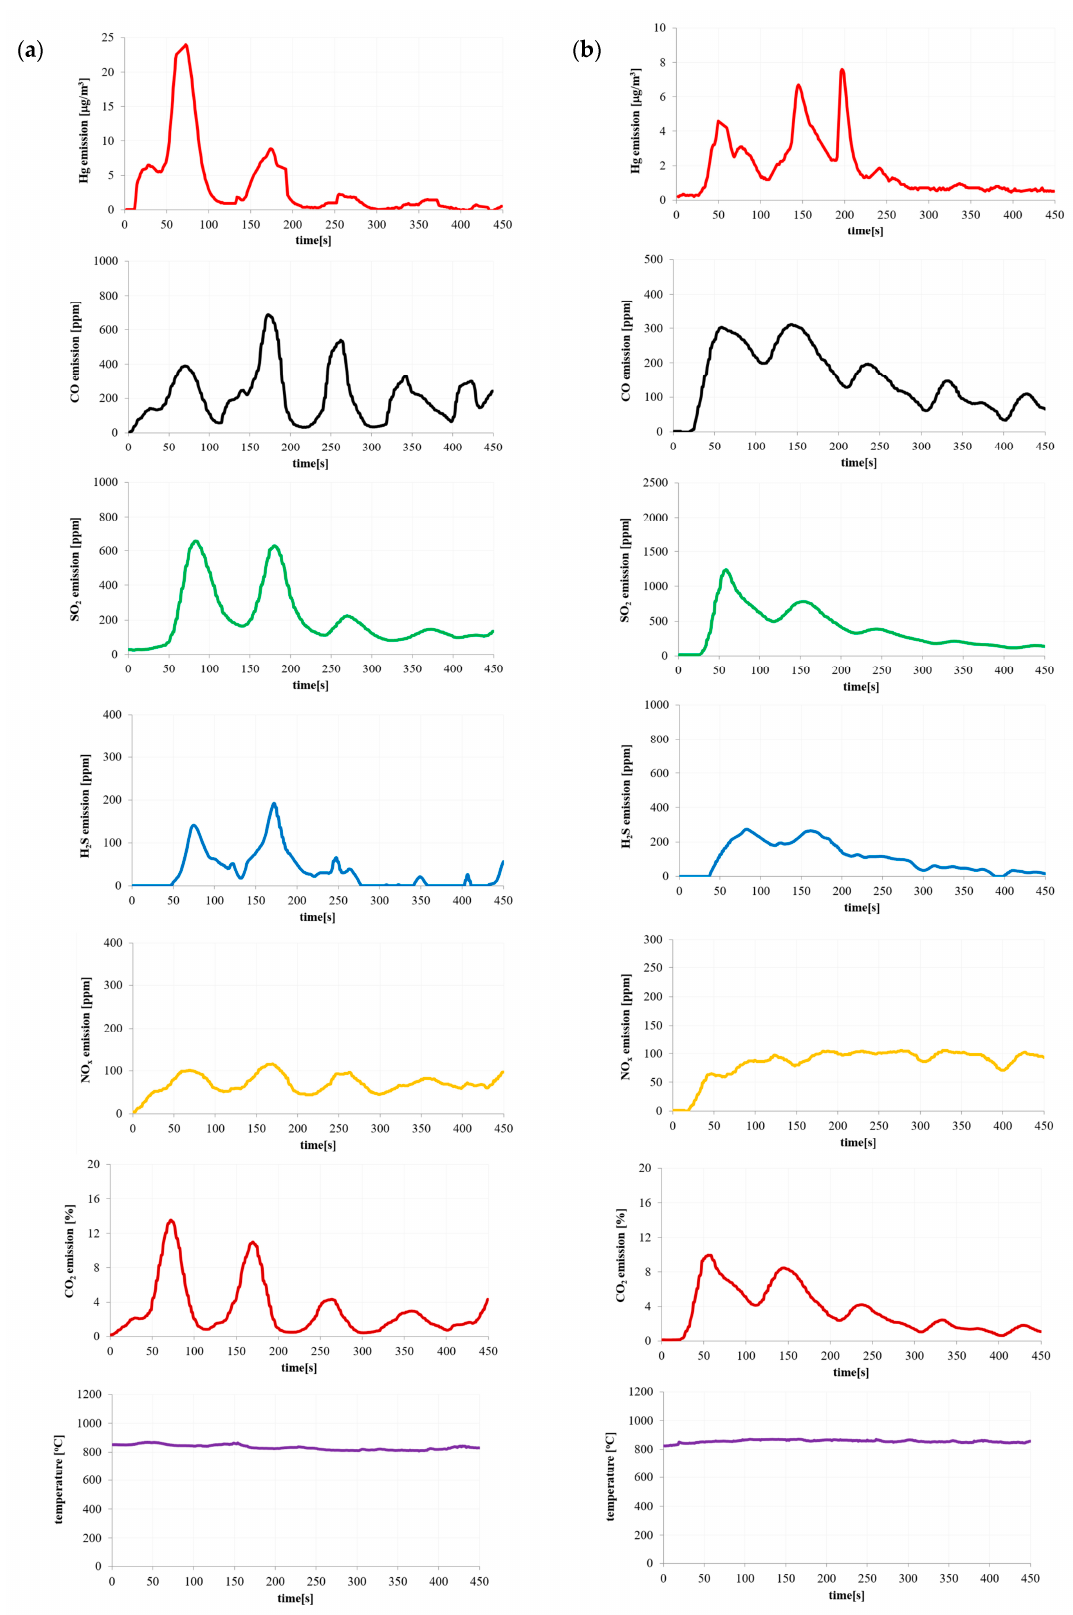
Figure 3. Emission of pollutants during ( a ) coke waste and ( b ) sewage sludge combustion.